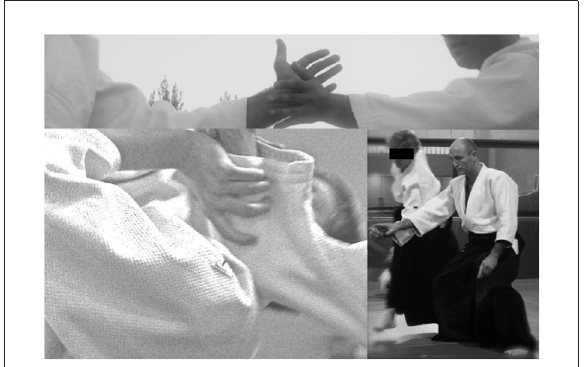
FIGURE1 Aikido: contact points between Uke and Tori, hand and forearm. In the 3rd frame Jesús Arce (Black Belt, 5 ◦ Dan) in demonstration of Tori provoking torsion in Uke.